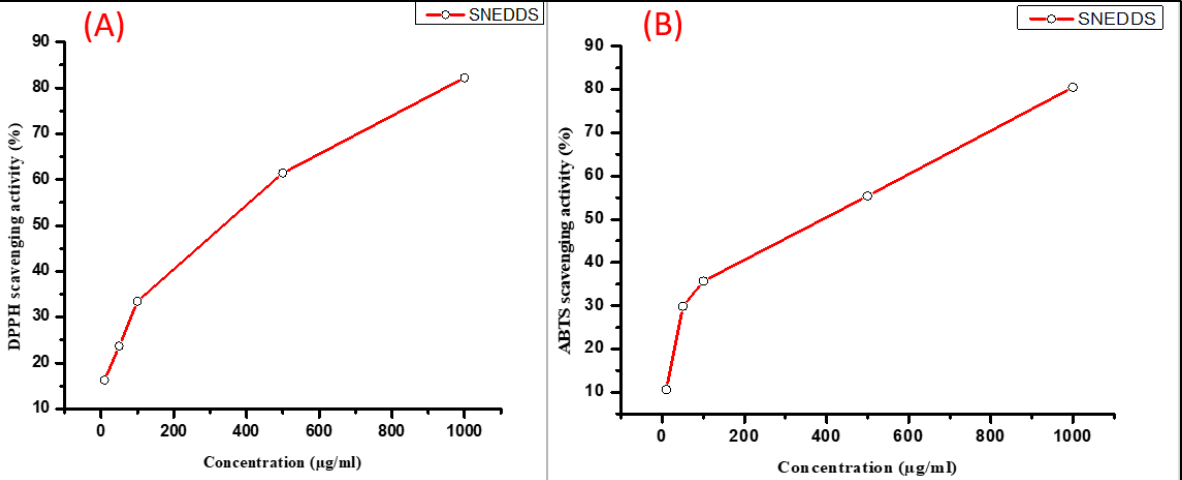
Figure 4. Antioxidant activities of the representative SNEDDSs. ( A ) DPPH scavenging activity and ( B ) ABTS scavenging activity. Data were analyzed using Origin Pro 8 software.